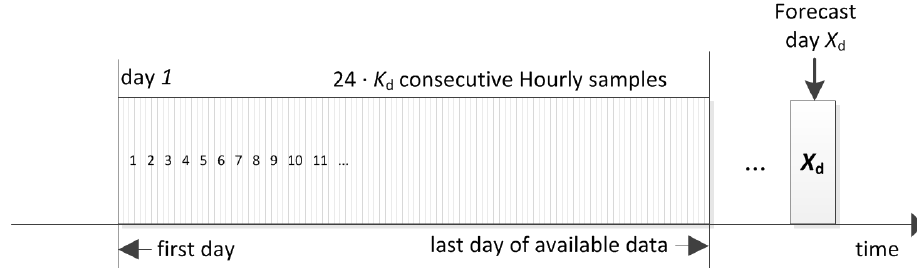
Figure 5. Hourly samples belonging to an extended period of time are available in a complete training